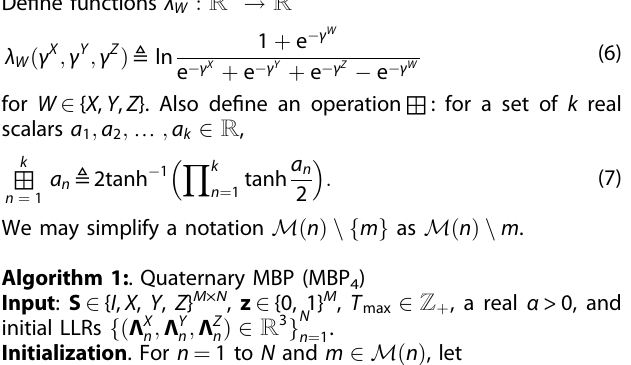
Algorithm 1: . Quaternary MBP (MBP 4 ) Input : S ∈ { I , X , Y , Z } M × N , z ∈ {0, 1} M , T max 2 Z þ , a real α > 0,